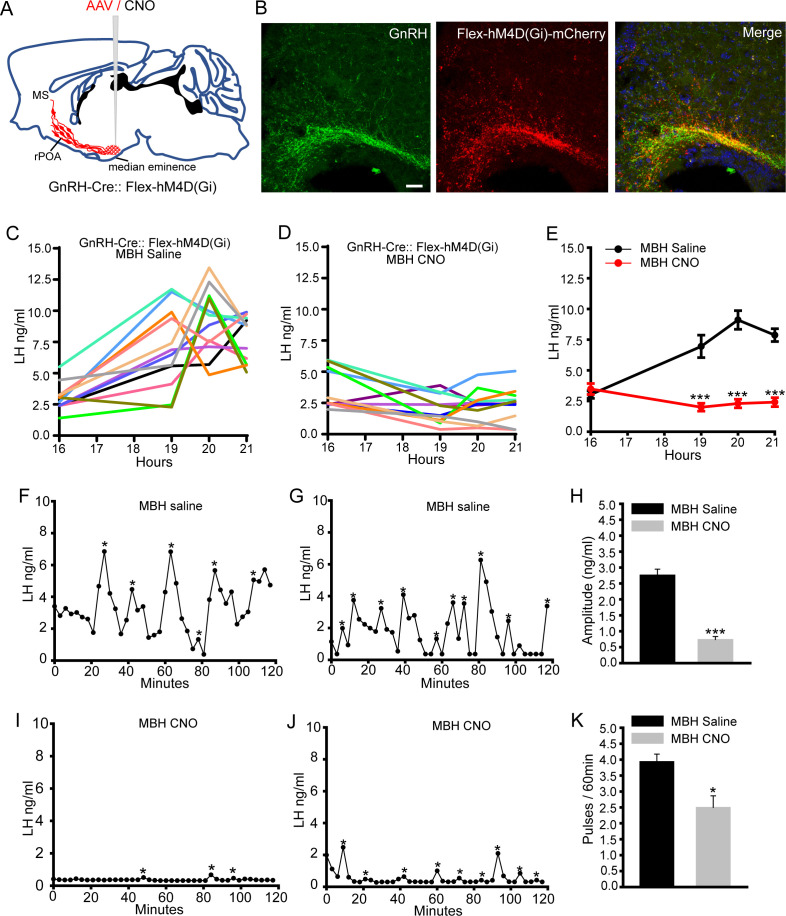
Chemogenetic inhibition of GnRH neuron distal dendron activity suppresses both the surge and pulse profiles of LH secretion.(A) Schematic showing experimental protocol with GnRH-Cre mice injected with Cre-dependent Flex-hM4D(Gi)-mCherry AAVs bilaterally into the region of the median eminence and CNO given into the same region. MS, medial septum. CNO, Clozapine N-oxide. (B) Fluorescence images of GnRH neuron projections in the vicinity of the median eminence expressing GnRH (green) and mCherry (red) in GnRH::Flex-hM4D(Gi)-mCherry mice. Scale bar, 20 μm. (C,D) LH surge profiles in all GnRH-Cre OVX+E+P female mice following MBH injection of saline (C, n = 12) or CNO (D, n = 12). (E) Mean (± SEM) LH levels. ***p<0.001, two-way repeated measures ANOVA with Holm-Sidak test. F-J. Representative examples of pulsatile LH secretion in OVX GnRH-Cre mice given saline (F,G) or CNO (I,J). LH pulses are indicated by asterisks. Mean (± SEM) amplitude (H) and frequency (K) of LH pulses in saline (n = 8) and CNO (n = 7). ***p<0.001,*p<0.05 Mann-Whitney U-tests.